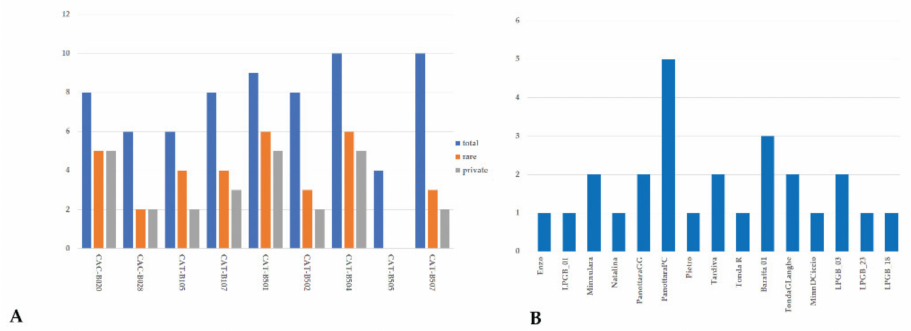
Figure 1. Distribution of rare and private alleles in each locus ( A ) and cultivars with private alleles ( B ) detected on 30 hazelnut genotypes sampled in the Nebrodi Mountains. Bruvo’s genetic distance among 30 hazelnut genotypes was used to build an Un- weighted Pair Group Method with Arithmetic Mean (UPGMA) dendrogram (Figure 2A).